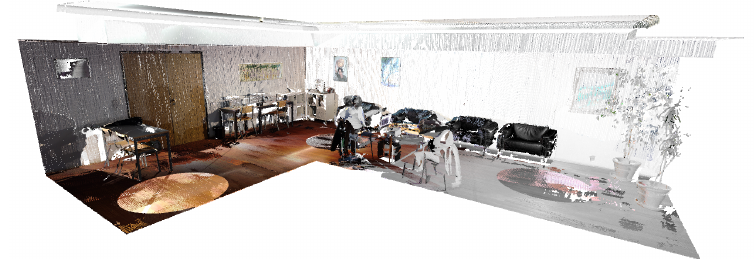
Figure 18. FARO laser scanned point cloud after downsampling and